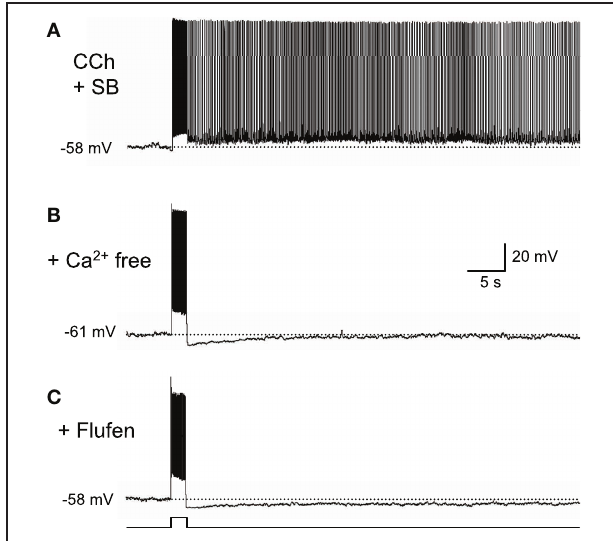
FIGURE 2 | Intracellular mechanism supports persistent firing. (A) Long-lasting persistent firing observed in synaptic blockers. Ionotropic glutamate (kynurenic acid) and GABA A (picrotoxin) blockers were used. (B) Persistent firing was not observed in the absence of calcium in ACSF. (C) CAN current blocker flufenamic acid blocked persistent firing. These results suggest that neurons in the postsubiculum have an ability to induce persistent firing with intrinsic mechanisms to the cells. SB, synaptic blockers; Flufen, flufenamic acid. Modified from Yoshida and Hasselmo